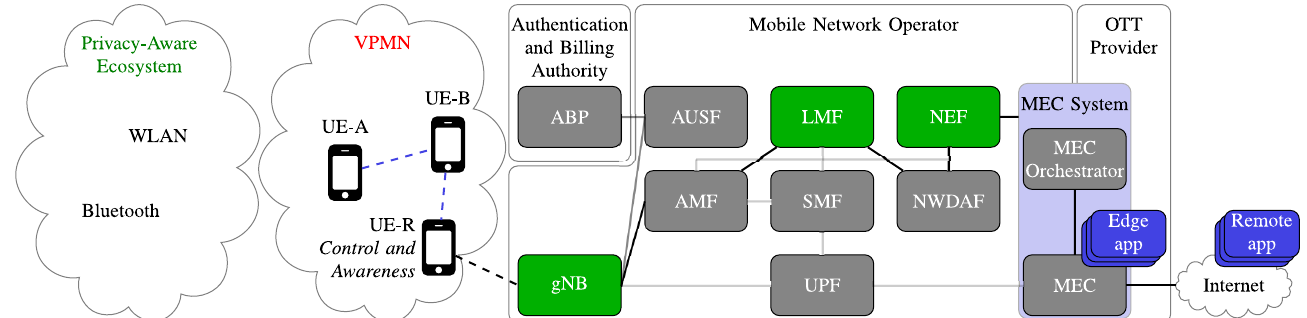
Figure 3. Main components of the location-privacy protection integrated solution, and their interactions. Black lines indicate functional interconnections for the exchange of location information. Dashed blue lines indicate exchanges of messages within the VPMN. Green boxes indicate the control by UE-A of location information in various other network functions.